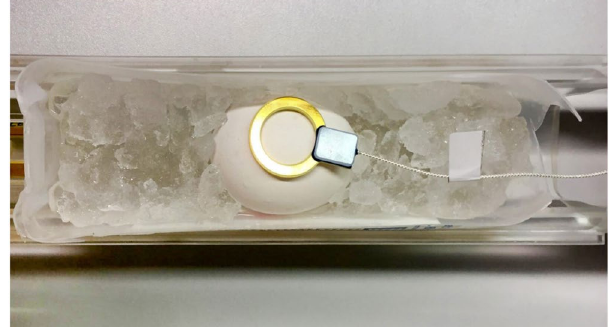
Figure 1. Egg with attached S1-torodial coil (golden ring) on a bed of crushed ice in a small plastic tray during cooling before